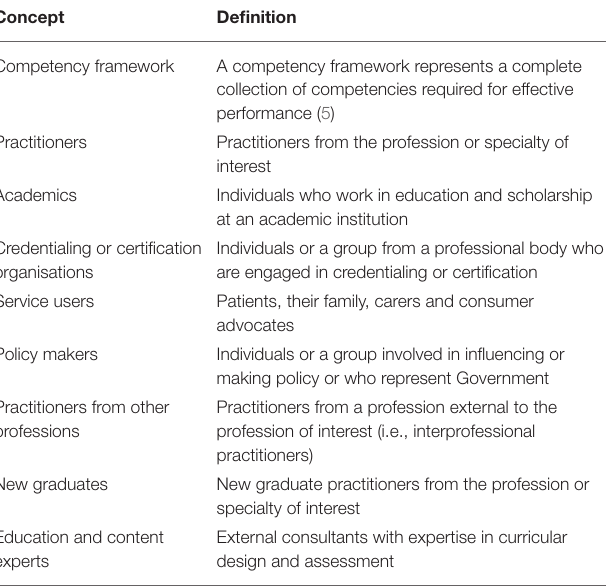
TABLE 1 | Definitions of key concepts and stakeholder